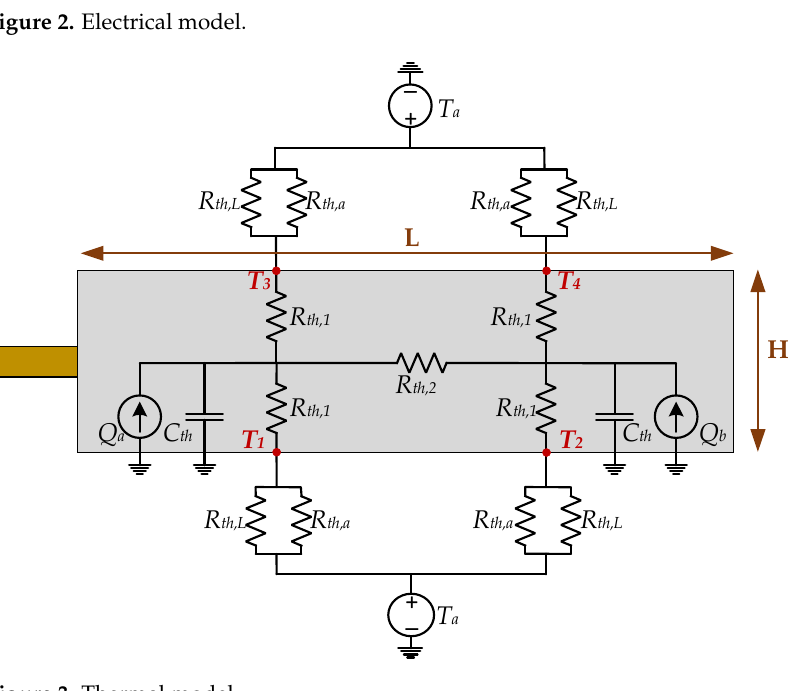
Figure 3. Thermal model. Figure 3. Thermal